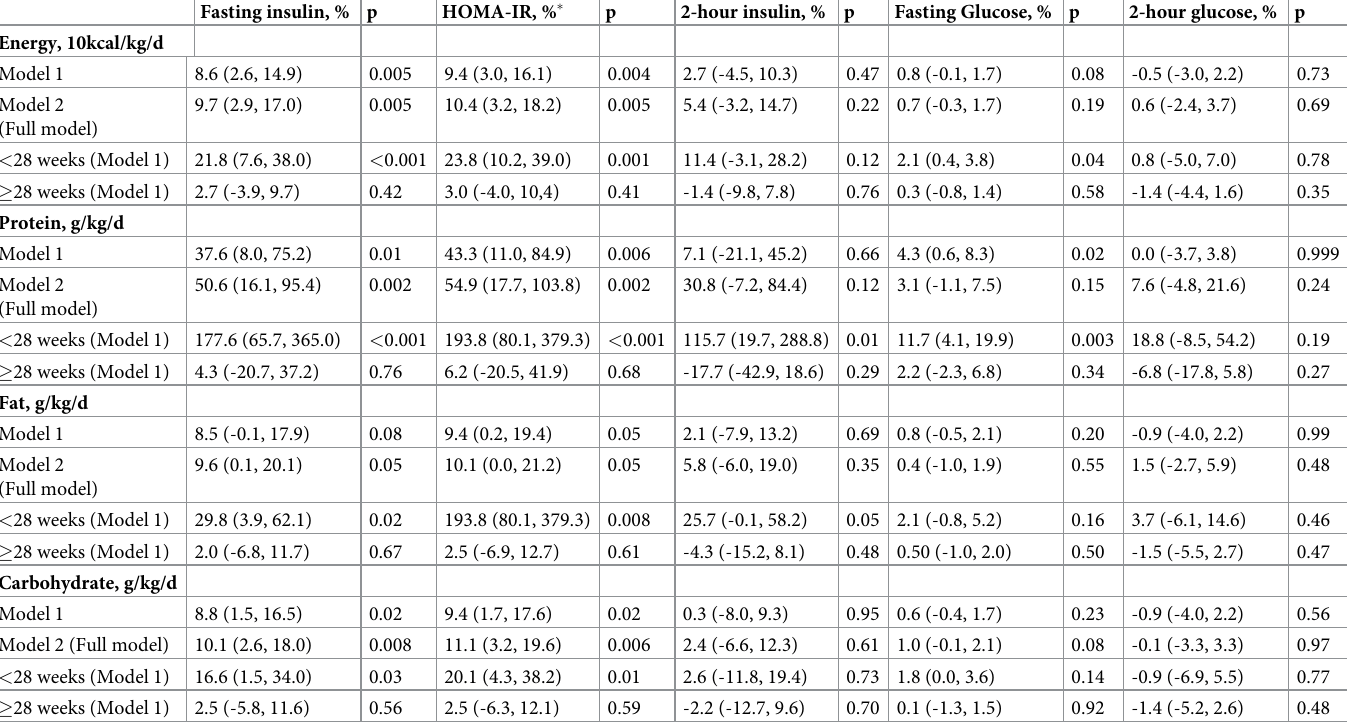
Table 4. Effect of the first 3 weeks of life energy and macronutrient intake of VLBW infants on a 2-hour glucose tolerance test in young adult life, by separate linear regression models. Fasting insulin, %